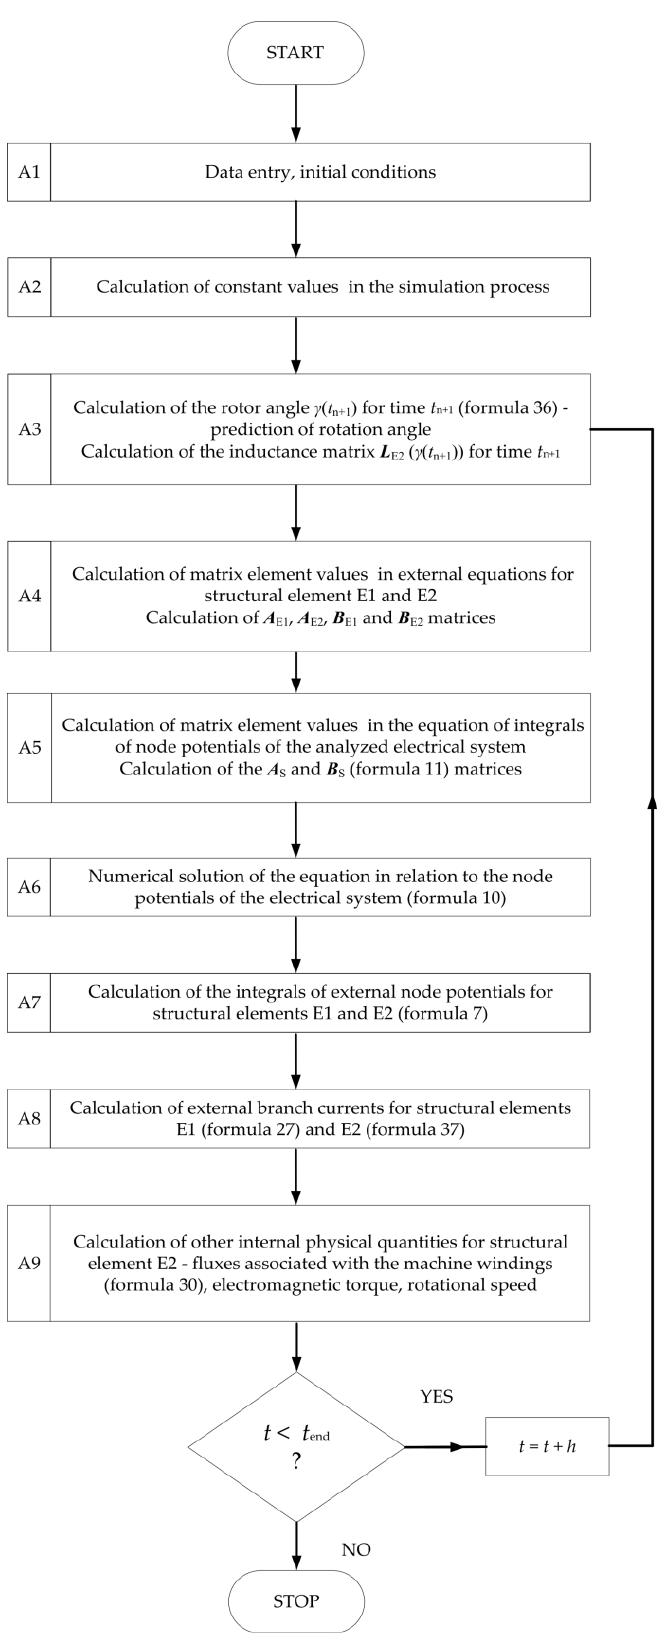
Figure 6. Algorithm for mathematical modeling of electromechanical systems with the use of electric multipoles and methods of average voltage values at the integration step.